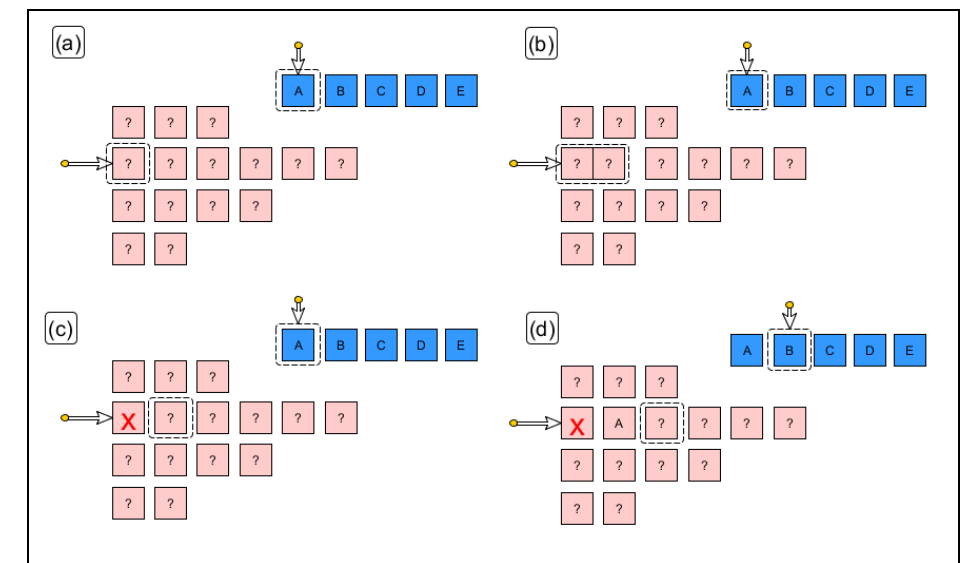
Figure 11. In ( a ) we select the second line of extracted shapes based on the minimum number of characters required by the expected line. The rationale behind the decision is that merging errors are rare. The first shape of the line is also selected. In ( b ) it is shown that if the match with one shape fails, it is merged with the next and matching is reattempted. In ( c ) it is shown that if the step in ( b ) has also failed, that extracted shape is discarded (it must be noise) and we move on to the next one. Finally, in ( d ) a positive match is made. We move on to the next expected character and the next extracted